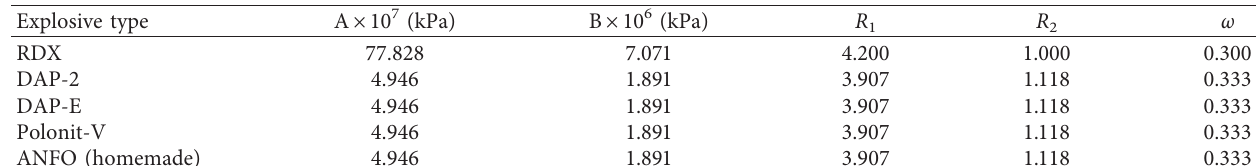
Table 3: Reference JWL EOS parameters for equation (9).